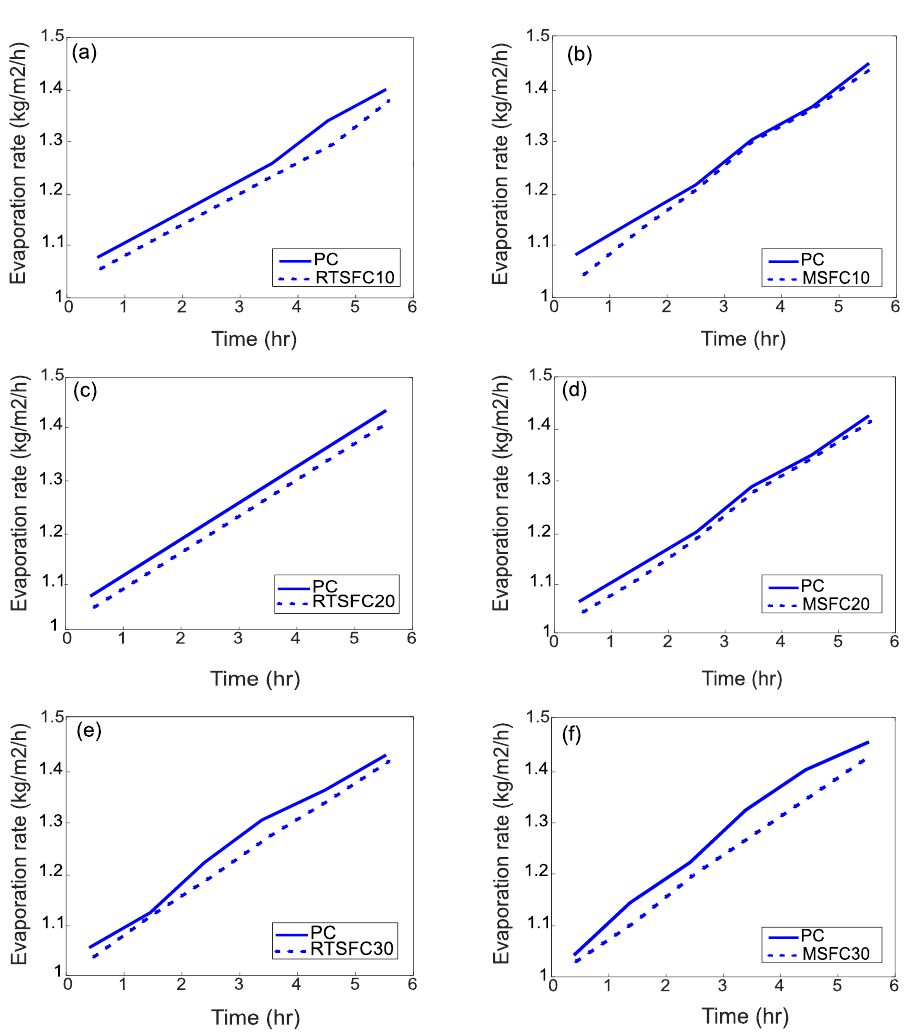
Figure 16. Evaporation rate of the various mixes compared to PC: ( a ) RTSFC10; ( b ) MSFC10; ( c ) RTSFC20; ( d ) MSFC20; ( e ) RTSFC30; ( f ) MSFC30.